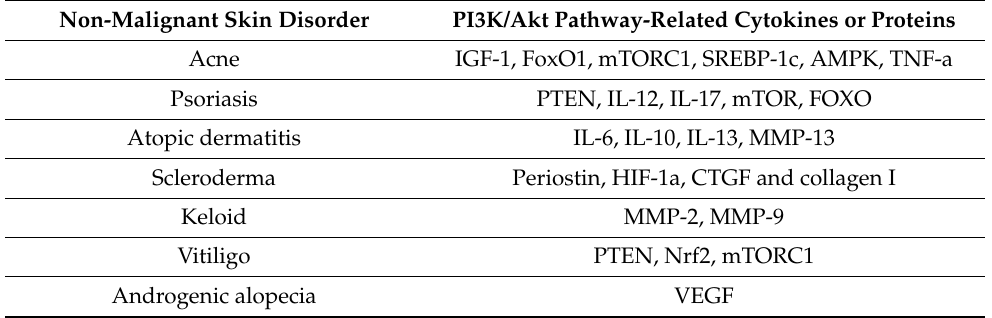
Table 1. PI3K/Akt pathway-related proteins and cytokines involved in non-malignant skin